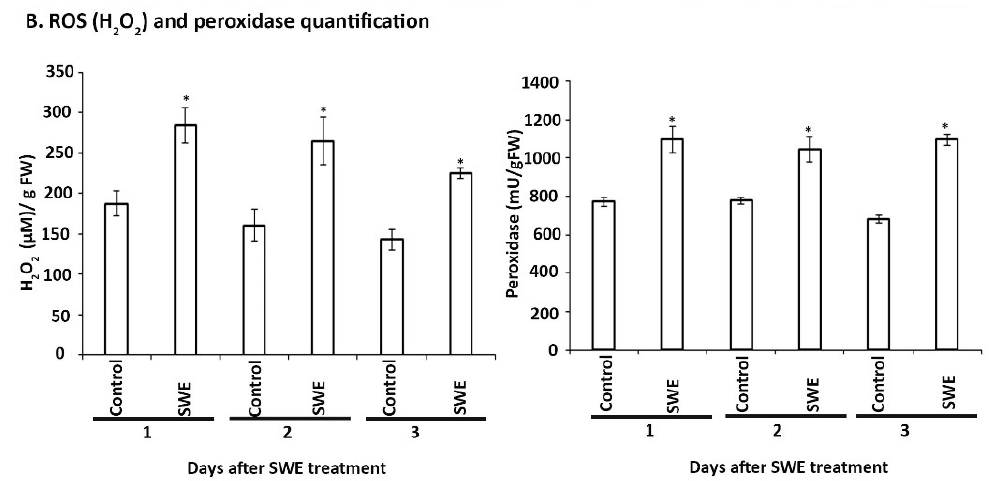
Figure 6. Detection and quantitation of hydrogen peroxide and peroxidase in S. lycopersicum roots grown in the sand culture system and treated with a single application of SWE or water as the control. ( A ). The SWE-treated roots harvested at 1, 2 and 3 days after the application showed higher production of H 2 O 2 compared to their respective control. Scale bar = 50 µ m. Individual root cells 2 days after SWE application were DAB positive. Scale bar = 20 µ m ( B ). H 2 O 2 and peroxidase quantification from tomato roots grown with SWE or water as the control. Data shown are the mean of three independent biological replicates (each replicate consisted of 10 plants) and bars represent the standard error of the mean. * denotes the significant difference in the treatment compared to the respective control at p < 0.05 according to Duncan’s multiple range